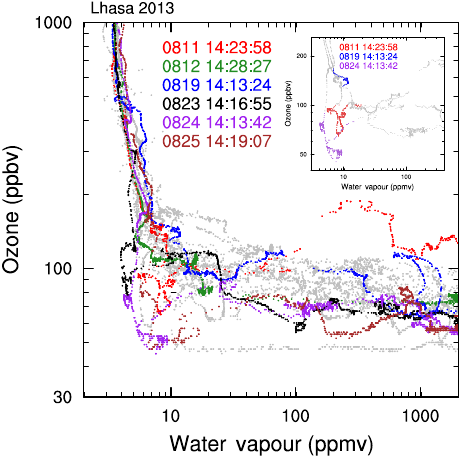
Figure 1. H 2 O–O 3 correlations for balloon profiles measured over Lhasa in August 2013 (grey colour). The profiles measured on 11– 12 August were impacted by tropical storm Jebi and measurements on 19 and 23–25 August were impacted by typhoon Utor or Trami. The layers of three profiles influenced by tropical cyclones are high- lighted